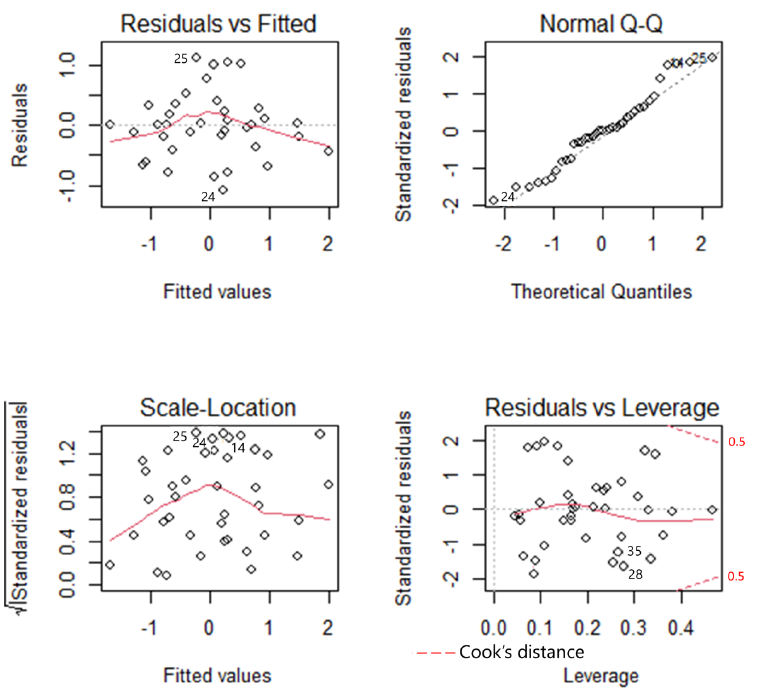
Figure A8. Model diagnostics for the best model with overall spring AA as the explained variable, and 15 climate variables and the Year as explanatory variables for the Willow Warbler Phylloscopus trochilus (Table